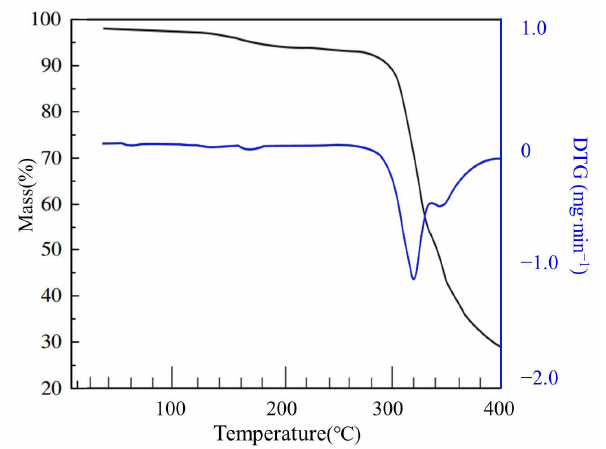
Figure 5. The TG and DTG curves of PAA-AM.